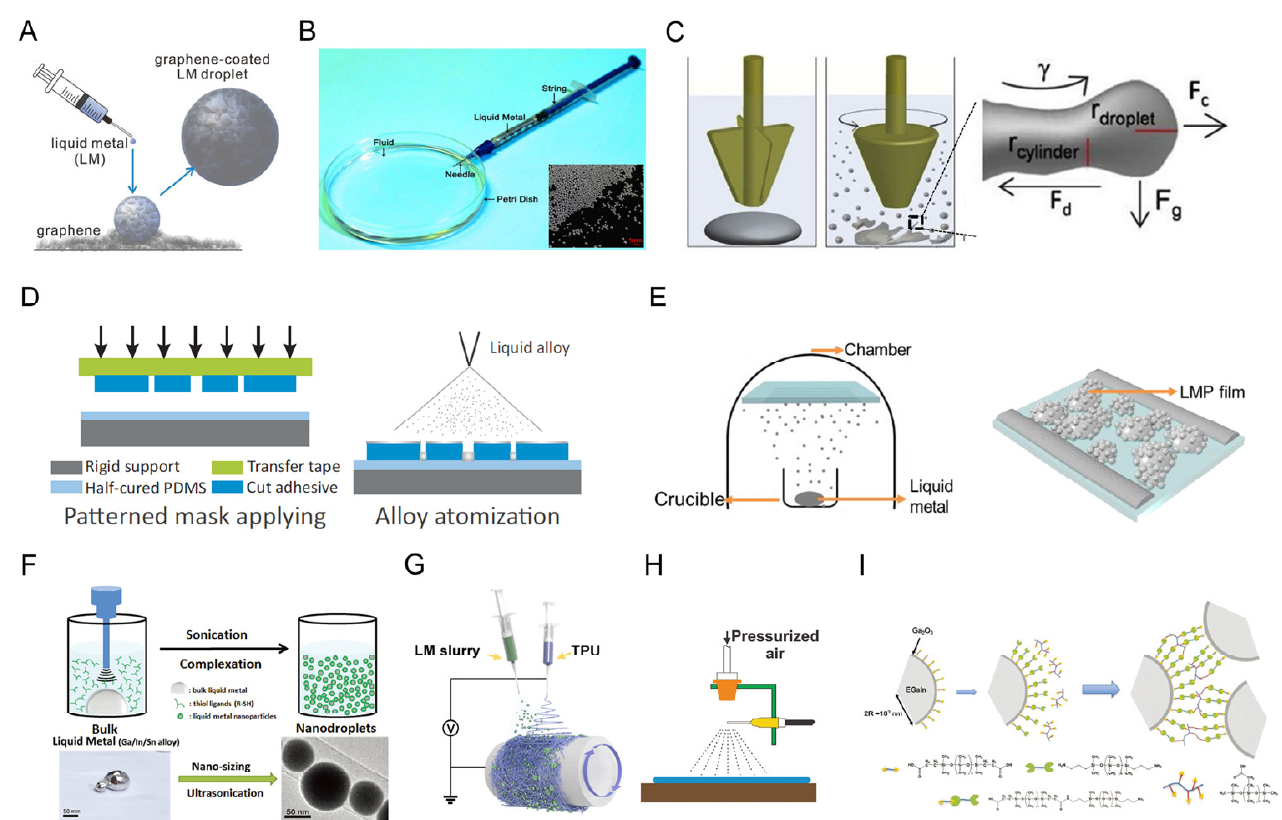
Figure 6. The fabrication strategies of LM-based conductive composites with size effect. ( A ) Schematic showing the generation process of graphene-coated liquid metal droplets [69]. Copyright: (2018) WILEY-VCH. ( B ) Device for injectable liquid metal droplets fabrication, and the inset image is the bottom view of liquid metal micro-droplets using a microscope [70]. Copyright: (2014) WILEY- VCH. ( C ) Schematic illustration of the SLICE process showing transformation of EGaIn into micro-